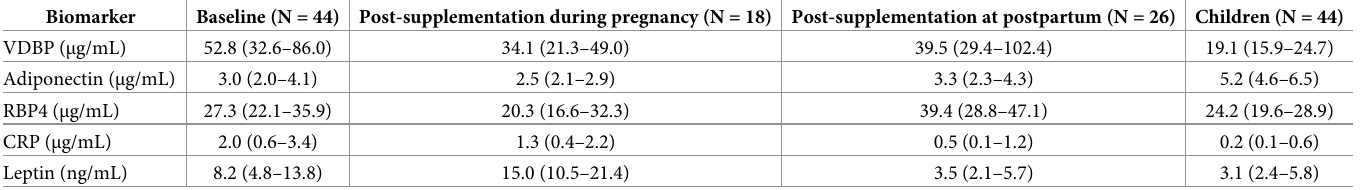
VDBP: vitamin D binding protein. RBP4: retinol binding protein. CRP: C-reactive protein. Data in median (interquartile range).